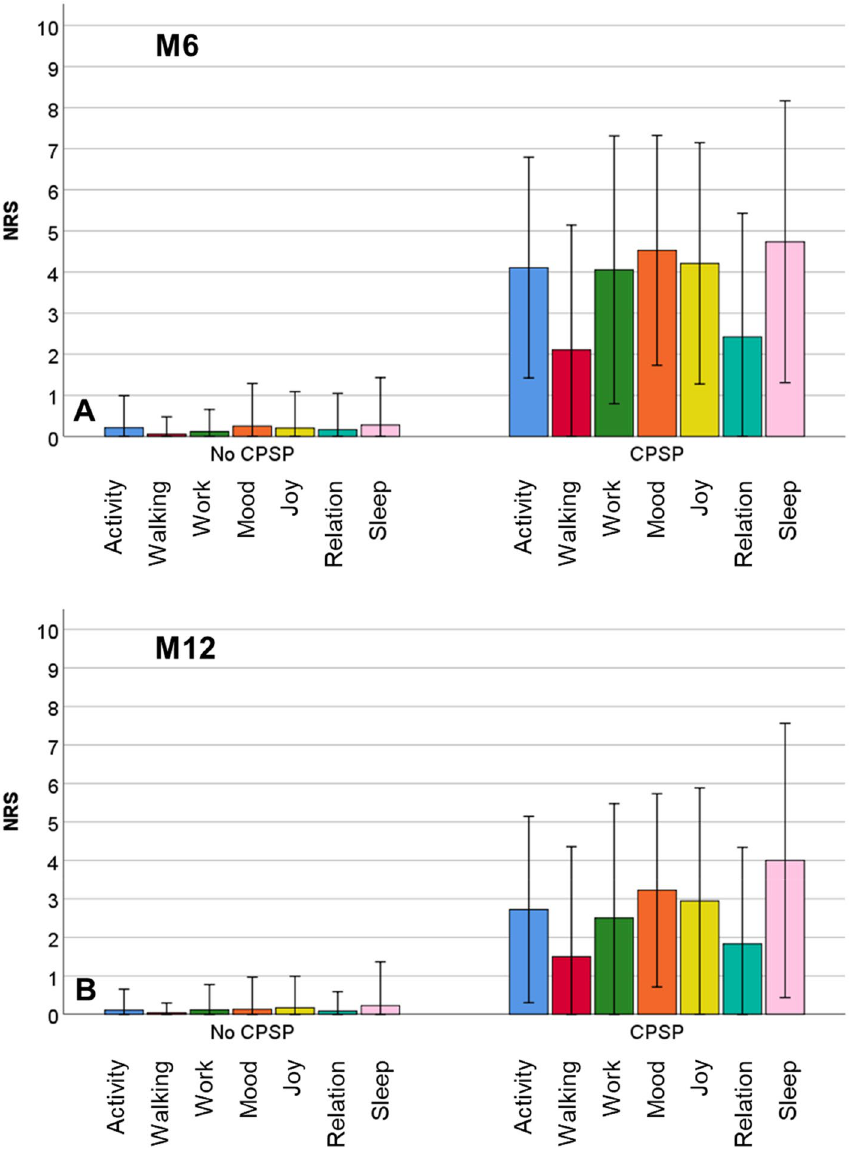
Figure 2. Average functional interference (Physical interference: general activity, walking ability, work; affective interference: mood, enjoyment of life, relations with other persons; and sleep interference) in patients without chronic postsurgical pain (CPSP) and with CPSP at M6 ( A ) and at M12 ( B ). NRS = numeric rating